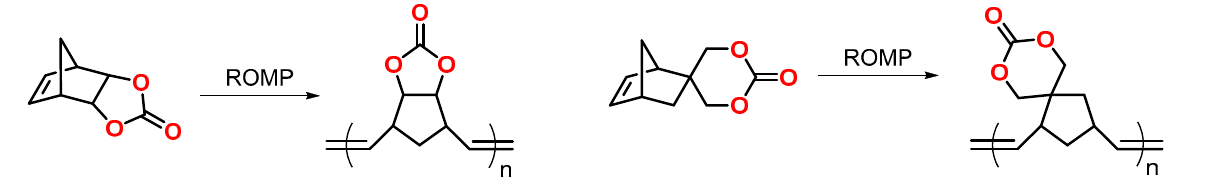
Figure 9. ROMP of norbornenes with five- and six-membered cyclic carbonate groups.